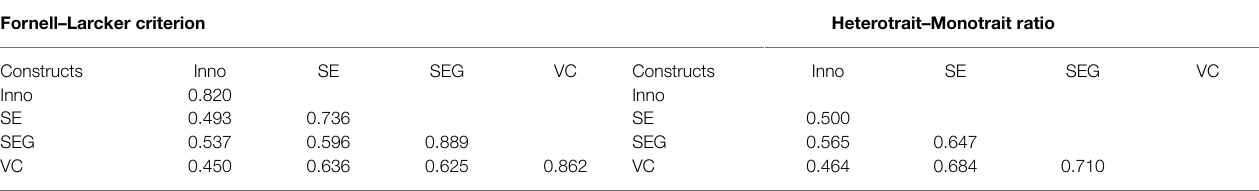
TABLE 3 | Discriminant validity.